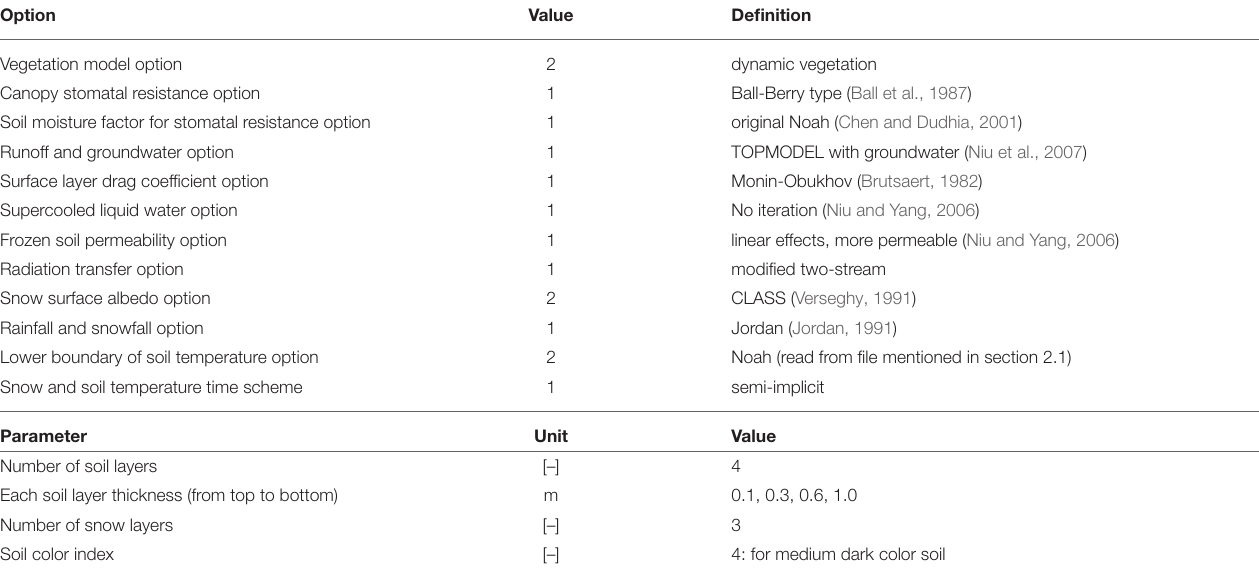
TABLE 1 | Noah-MP model runtime options and parameters used in this study.